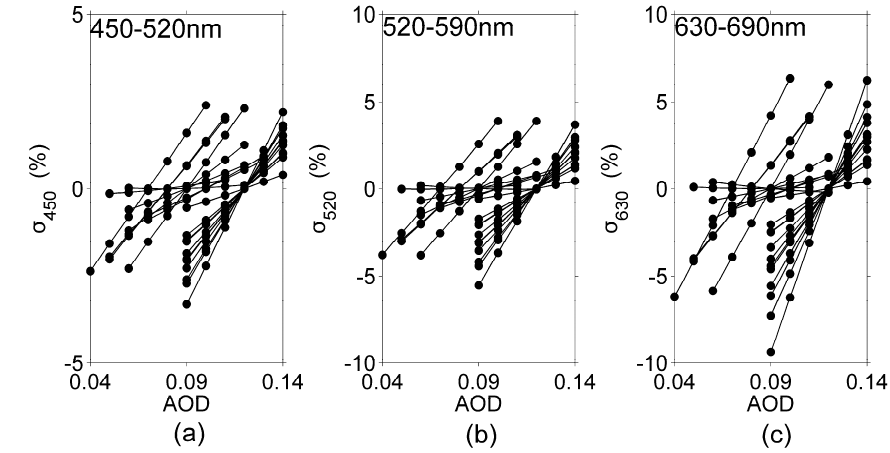
Figure 6. σ i (%, coefficient uncertainty with Aerosol Optical Depth (AOD) changes in steps of 0.01) of 22 examples varying with AOD at wavelengths of: ( a ) 450–520 nm; ( b ) 520–590 nm and ( c ) 630–690 nm (each line represents σ i of one calibration sample with AOD